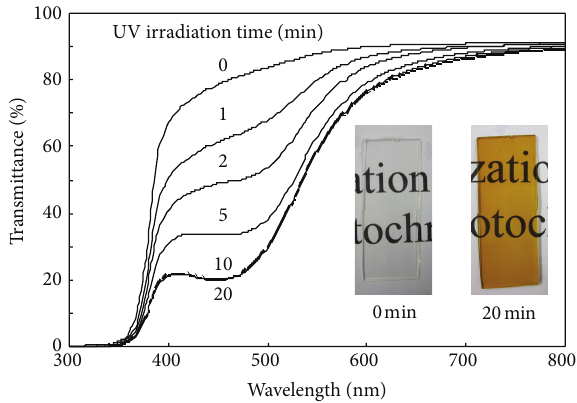
Figure 1: Transmission spectra of composite films with Cu/Ag atomic ratio of 1.0 at different UV-vis irradiation